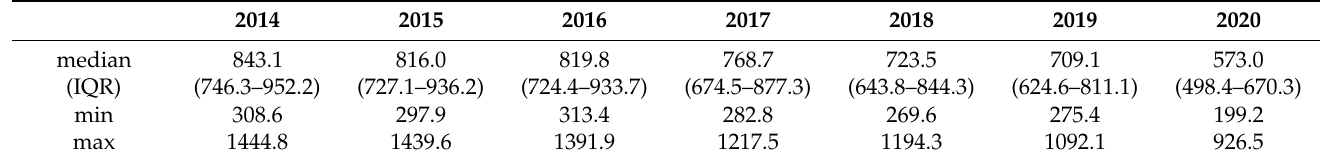
Table 2. Summary statistics for the standardised number of antibacterial drugs (per 1000 registered patients).